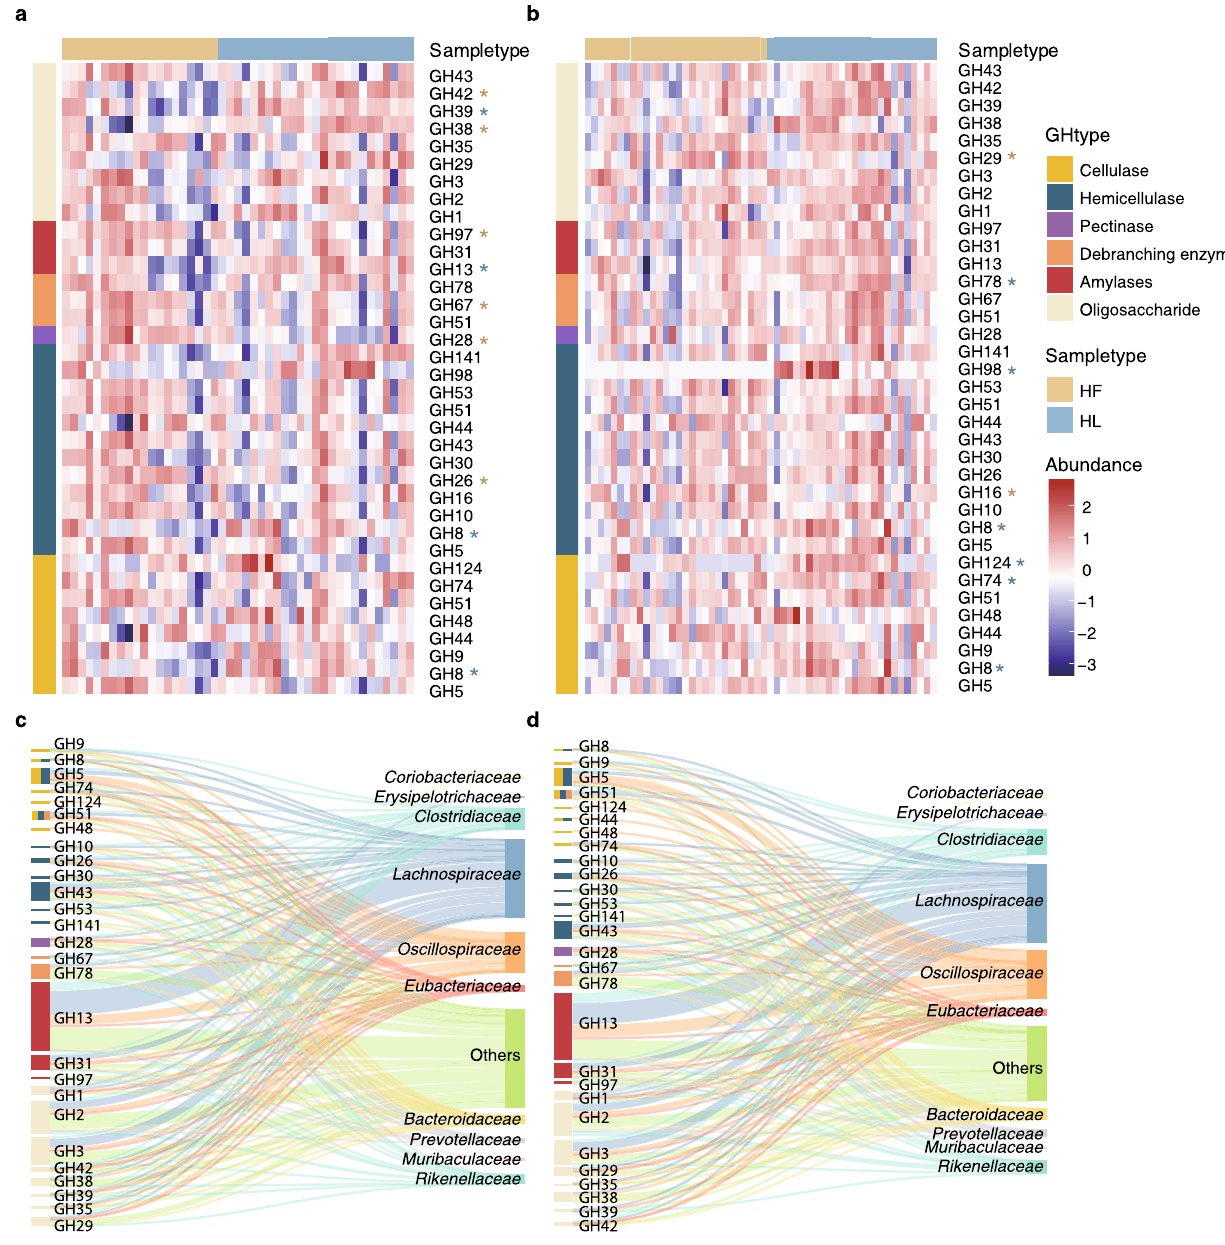
Fig. 6 CAZymes pro fi le adapted to polysaccharide metabolism. a and b Heatmap of the CAZymes pro fi le in the gibbon gut metagenomes ( a A2; b B2). CAZymes associated with cellulase, hemicellulase, pectinase, debranching enzymes, amylases, and oligosaccharide degradation were presented. CAZymes families with signi fi cant enrichment (Wilcoxon rank-sum test, and FDR-corrected p -value < 0.05) in the leaf- and fruit-dominated periods were marked. The standardized relative abundances of each CAZymes family were shown. c and d Sankey diagram describing the distribution of the top 10 microbial families associated with all selected CAZymes families ranked by the number of genes in gibbons A2 ( c ) and B2 ( d ). CAZymes were represented by different colors according to functional types and microbes were colored according to the associated families. The heights of the rectangles indicated the numbers of the CAZymes (left) and microbial species (right). The detailed information on the genes was summarized in Supplementary Table